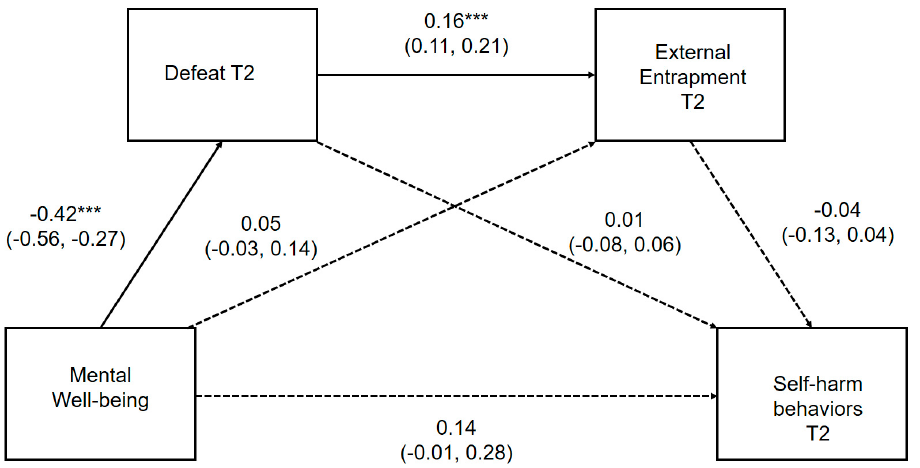
Figure 6. Serial multiple mediation model for the association between mental well ‐ being and prospective self ‐ harm behaviors, via defeat and external entrapment. *** p < 0.001 Serial multiple mediation model with unstandardized regression coefficients and 95% bias corrected confidence intervals. Significant pathways are highlighted in bold.